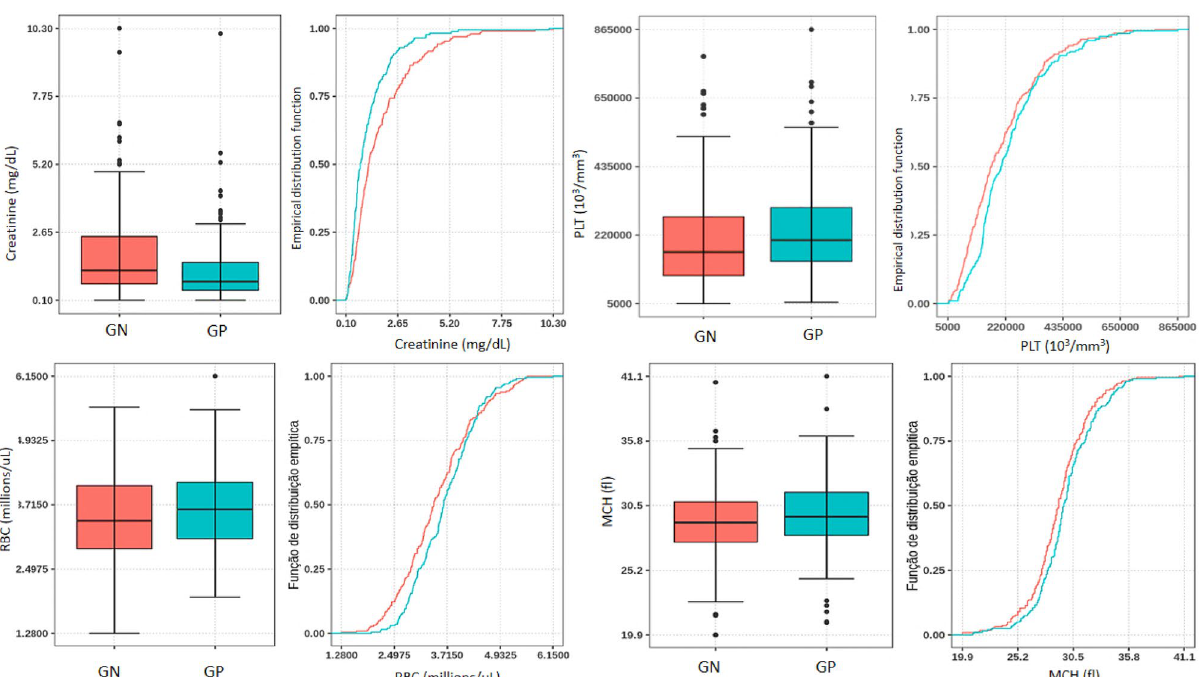
Figure 2. Comparisons of levels of single biomarkers stratified by patient categories. GN = Gram-negative (red); GP = Gram-positive (blue); PLT = platelet count; RBC = red blood cell count; MCH = mean corpuscular